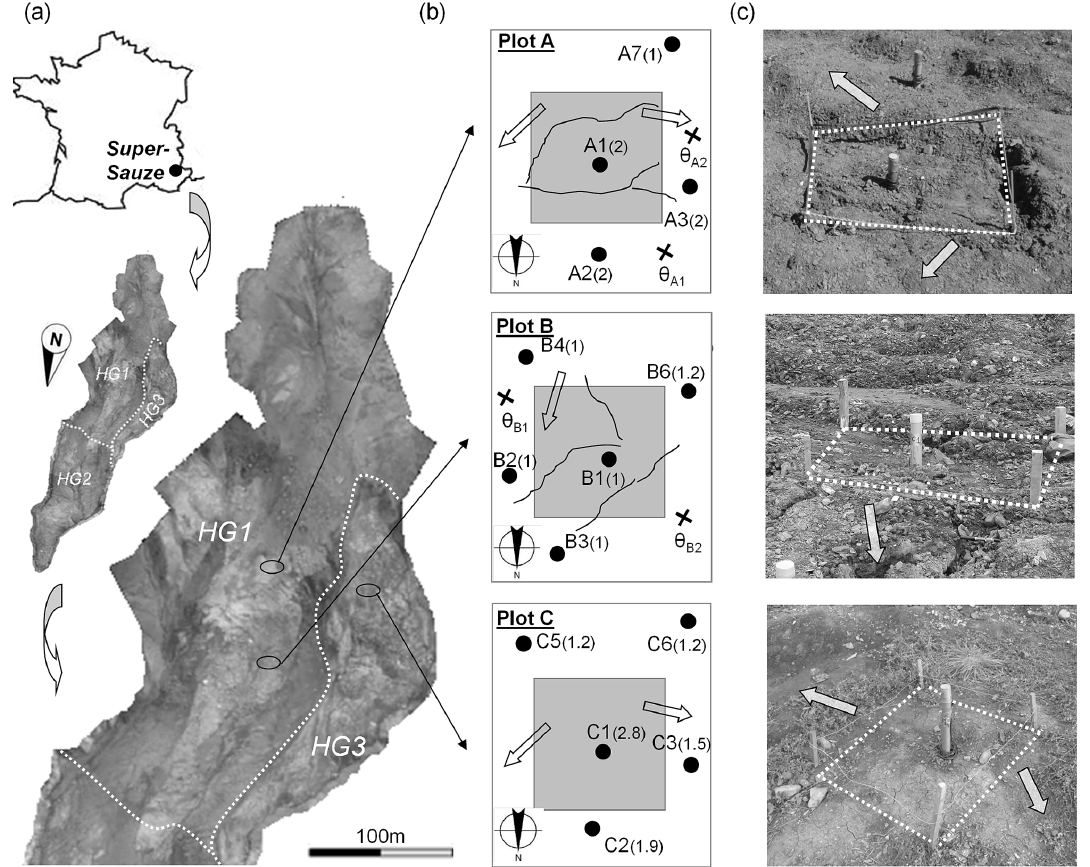
Figure 1. (a) The upper part of the Super-Sauze landslide with indicated location of three sprinkling tests (plot A, B and C); the white dashed lines indicate the hydro-geomorphological units (after Malet et al. 2005). (b) Schematic representation of the experimental setup of each area (not scaled): grey squares represent 1 × 1m 2 sprinkling plots, dots represent the location of the piezometers, numbers in brackets indicate the depth of the piezometers in metres, crosses indicate the location of the theta probes, undulating lines indicate fissure distribution within the sprinkling plots, and arrows show the local slope direction in the area. (c) Photographs of the soil surface of each sprinkling area with arrows showing the local slope direction in the